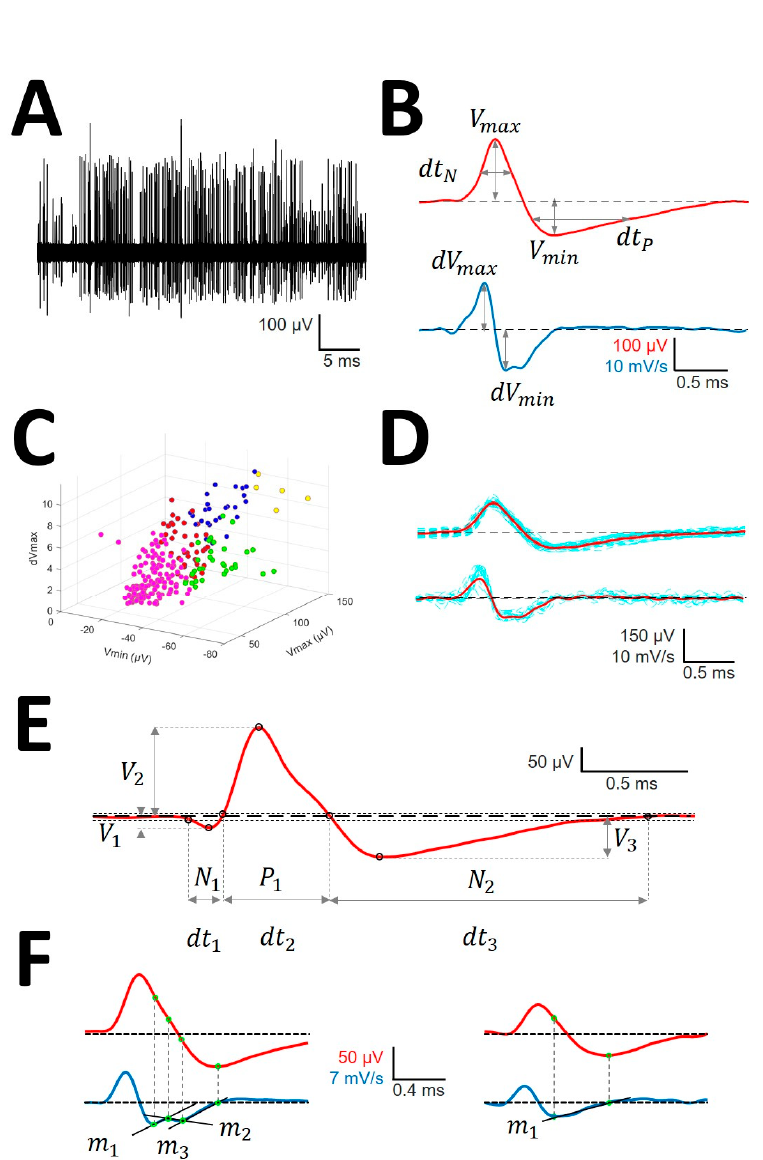
Figure 1. Sorting and analysis of action potential (AP) ( A ) Raw recording showing AP as vertical lines of different amplitude; ( B ) AP (upper row) and first derivative (lower row) showing the definitions of variables computed for sorting; ( C ) clustering in different units (identified by different colors) of the raw trace. Only three dimensions are shown, although clusterization used up to 6. ( D ) Mean AP (mAP) (upper row) and mean derivative (mDAP) (lower row) in red obtained from AP and dAP of similar morphology (blue lines). ( E ) Example of mAP showing the definition of variables analyzed. Tick dashed line represents basal voltage, and thin dotted lines represent upper and lower thresholds used to characterize the structure. Dots are the fiducial points used to define amplitudes and phases. ( F ) mAP (red, upper row) and mDAP (blue, lower row) showing different phases during repolarizing period. The left column shows a mAP with three different phases fitted to functions with different slopes ( m 1 , m 2, and m 3 ) and the right one shows as mAP with only one phase ( m 1 ).